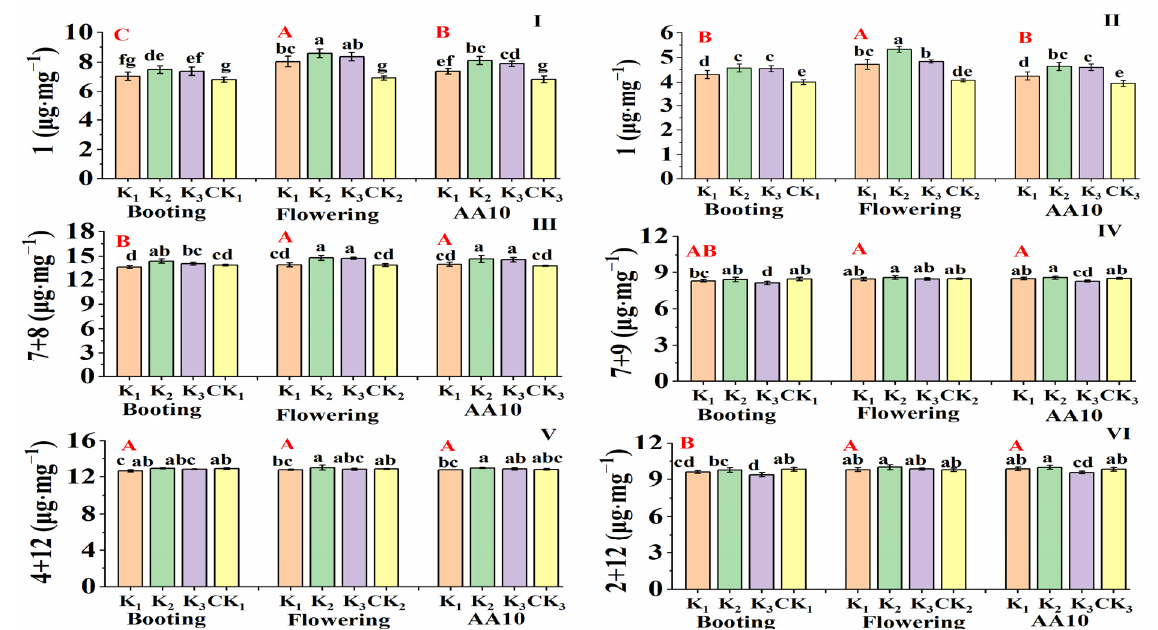
Figure 8. Variation of HMW-GS content in Xinong 20 and Xiaoyan 22. Ⅰ , Ⅲ , and Ⅴ represented Xinong 20, Ⅱ , Ⅳ , and Ⅵ represented Xiaoyan 22. Booting (BBCH 48), Anthesis (BBCH 65), and AA10 (BBCH 71): Potassium fertilizer foliar sprayed at booting stage, anthesis stages, and 10 days post anthesis, respectively. K 1 , K 2 , and K 3 represented the application concentration of potassium 30, 60, and 90 mmol L − 1 , respectively. CK: Same amount of deionized water was sprayed on the leaves. Vertical bars represent the mean values ± standard deviation (n = 3). Different lower-case letters indicate a significant difference ( p < 0.05). Different capital letters indicate a significant difference ( p < 0.05) among different spraying stages.